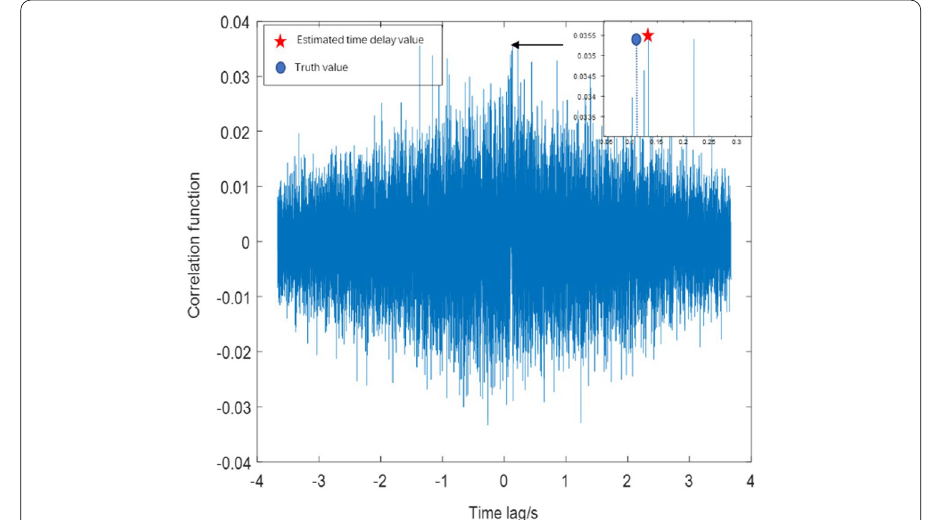
Fig. 9 Generalized cross-correlation method (SNR